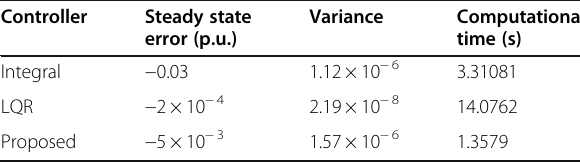
Table 4 Performance comparison of controllers corresponding to a measurement noise variance of